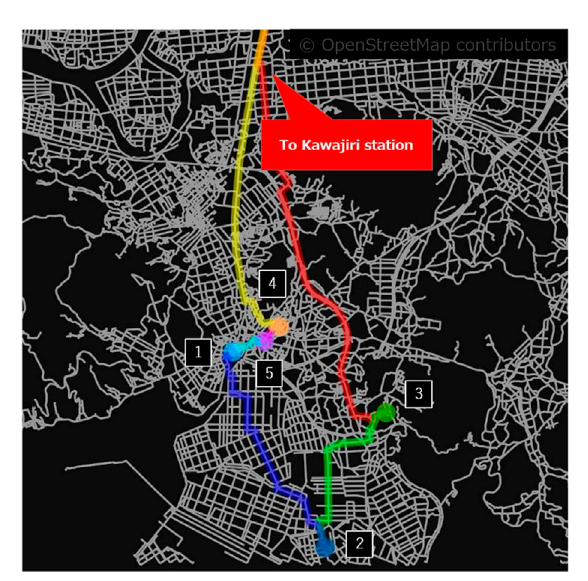
FIGURE 4 Route visualization for cluster No. 1 in instance No. 1 of the base case (paths are represented by red, green, blue, light blue, purple, and yellow in that order).